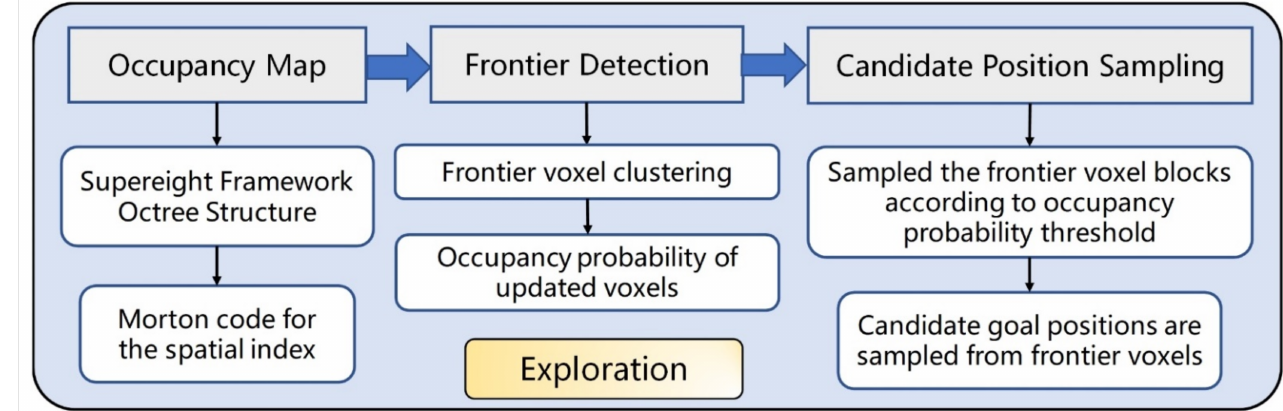
Figure 3. Diagram of proposed autonomous exploration structures: Occupancy map, Frontier detection and Candidate position